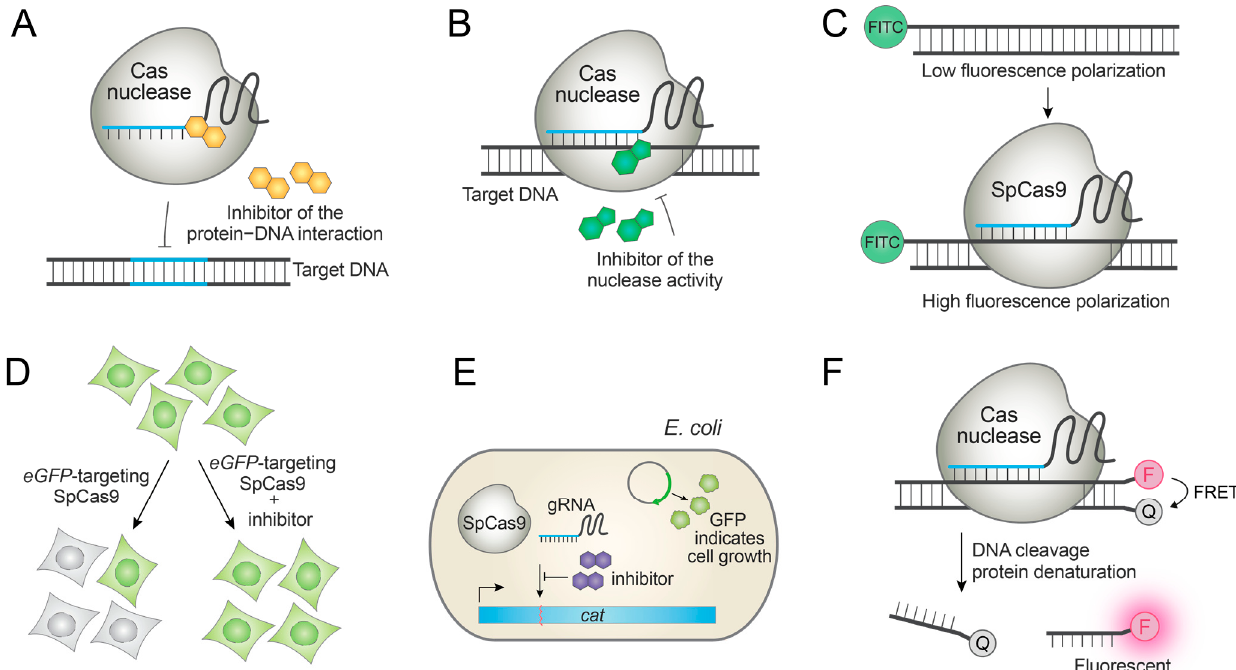
Figure 3. Discovery of anti-CRISPR molecules to inhibit native Cas nucleases. ( A , B ) Anti-CRISPR molecules display different modes of action, including ( A ) inhibition of the Cas nuclease − DNA interactions, and ( B ) inhibition of the nuclease domains. ( C ) A high-throughput in vitro fluorescence polarization assay to detect SpCas9 − PAM (protospacer adjacent motif) interactions. ( D ) An image-based high-content assay to identify SpCas9 inhibitors in human cells. ( E ) A cell-based assay to identify SpCas9 inhibitors in E. coli . ( F ) A high-throughput in vitro FRET assay to identify SpCas9 inhibitors.